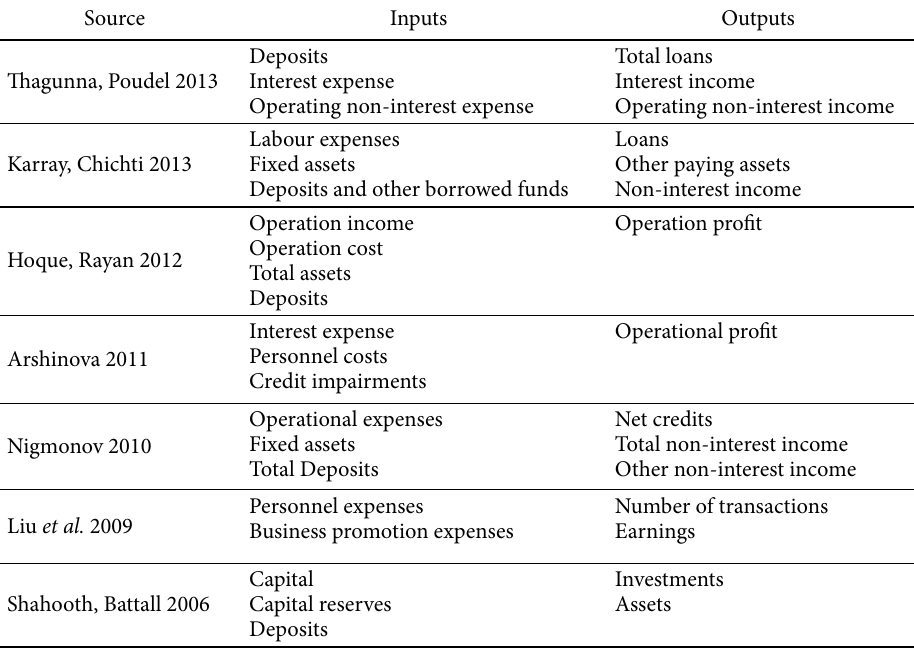
Table 2. Combination of inputs and outputs employed in DEA models Source